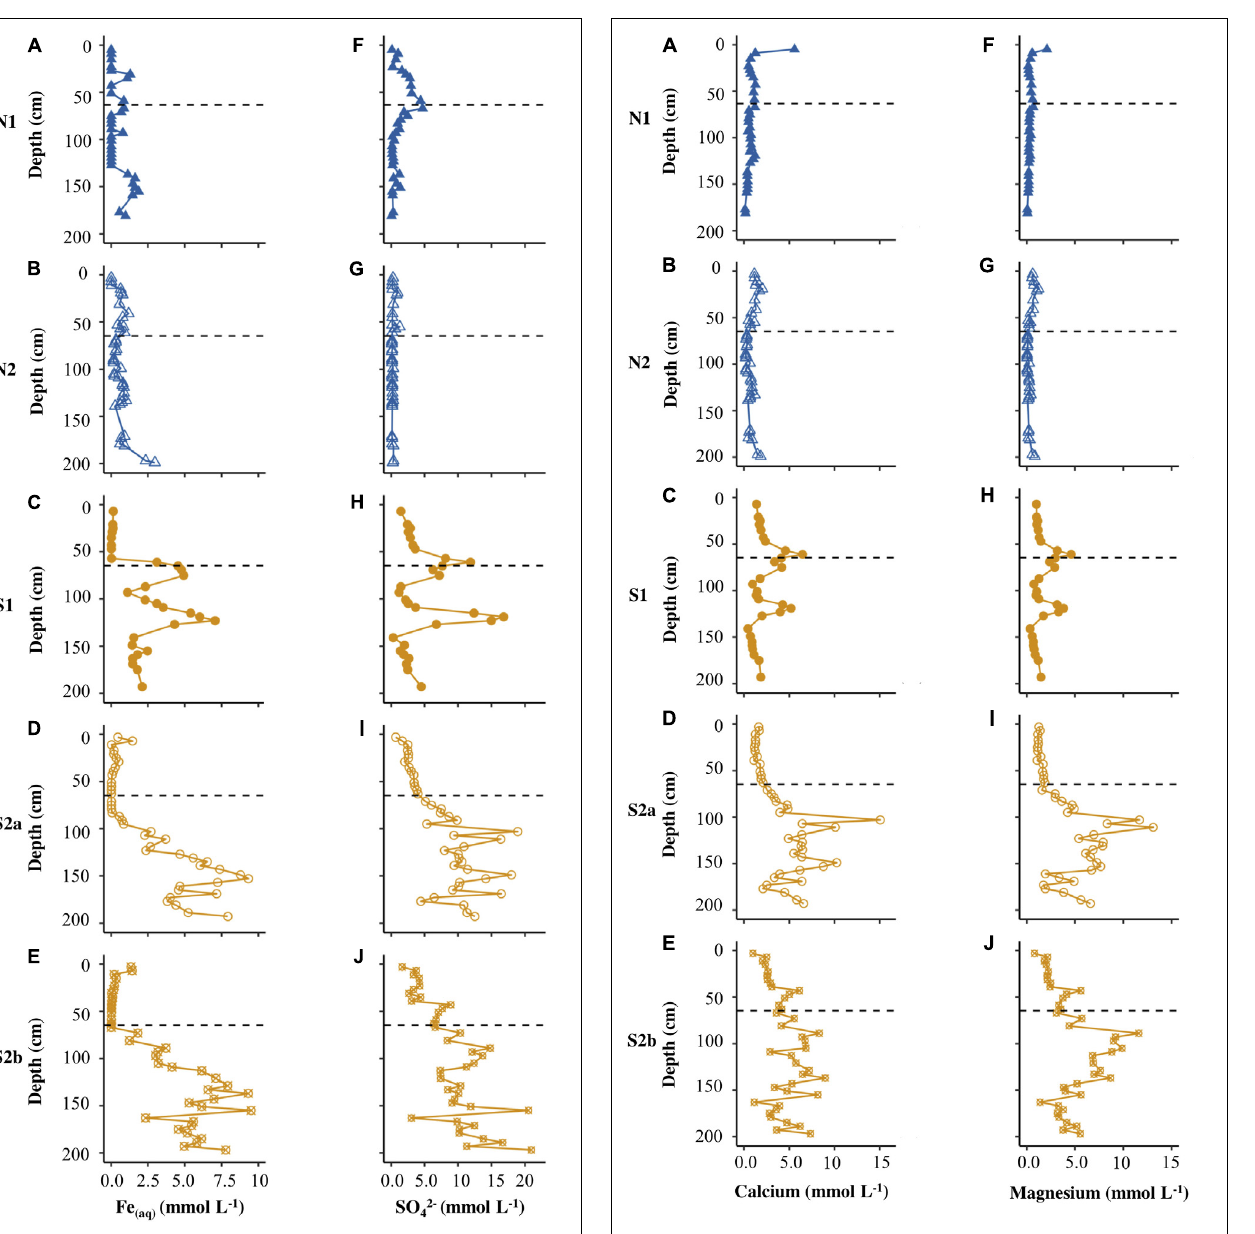
FIGURE 3 | Depth profiles of Fe ( aq ) (A–E) and SO 2 − 4 (F–J) for N1, N2, S1, S2a, and S2b. The horizontal dashed line on each plot represents the base of the active layer in 2017.